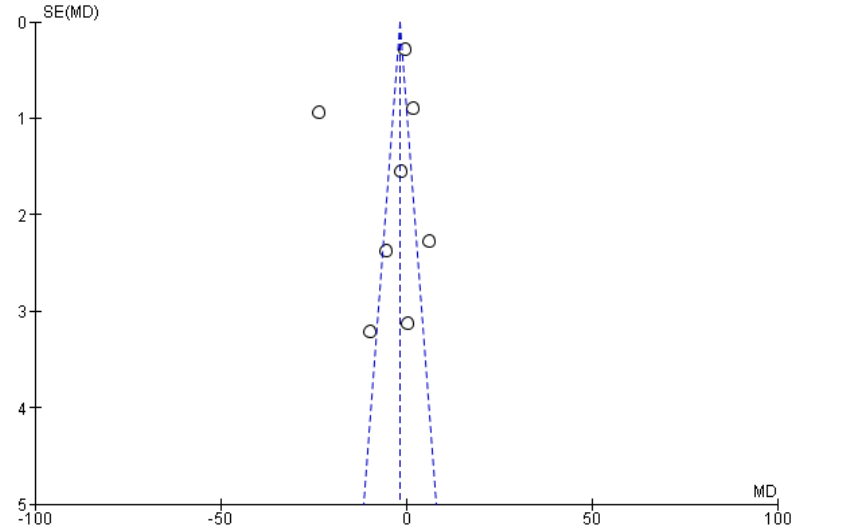
Figure 11. Funnel plot for maxillary expansion between experiment and control.